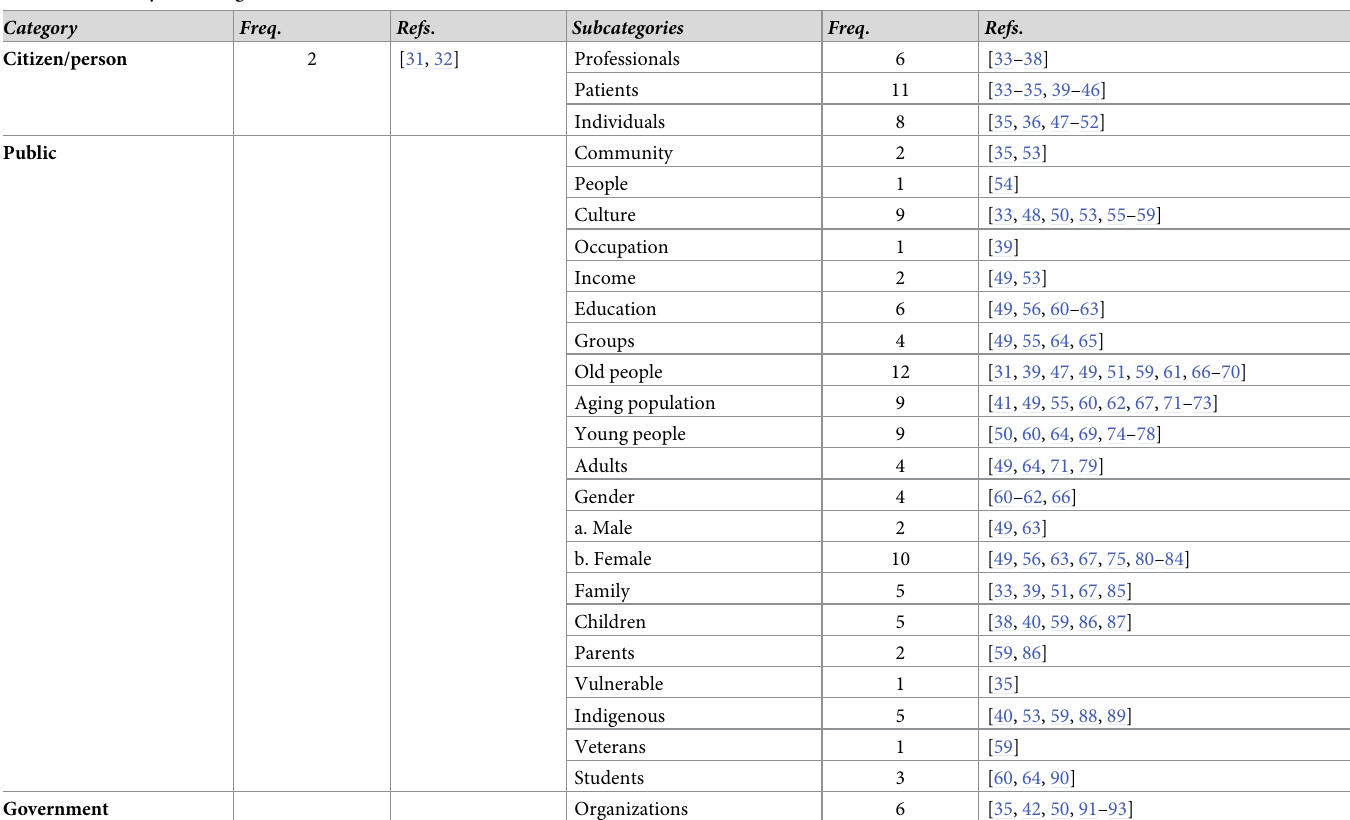
Table 4. Summary of findings in the reviewed literature: Consumer and user. Category Freq